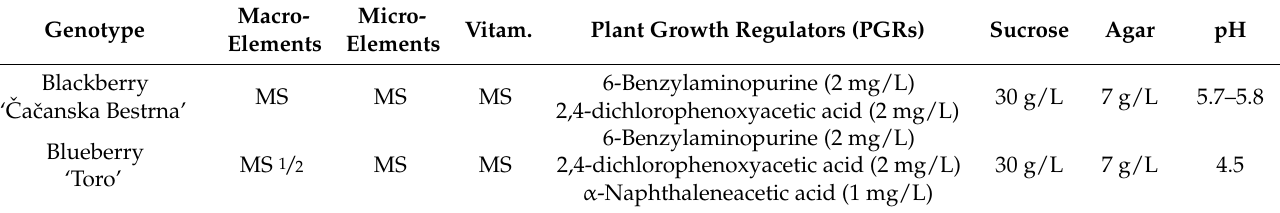
Table 2. Composition of media used for callus